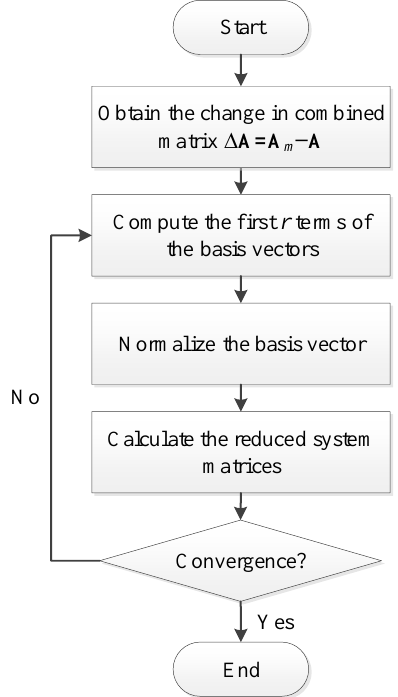
Figure 3. Flowchart of the modal repeated analysis